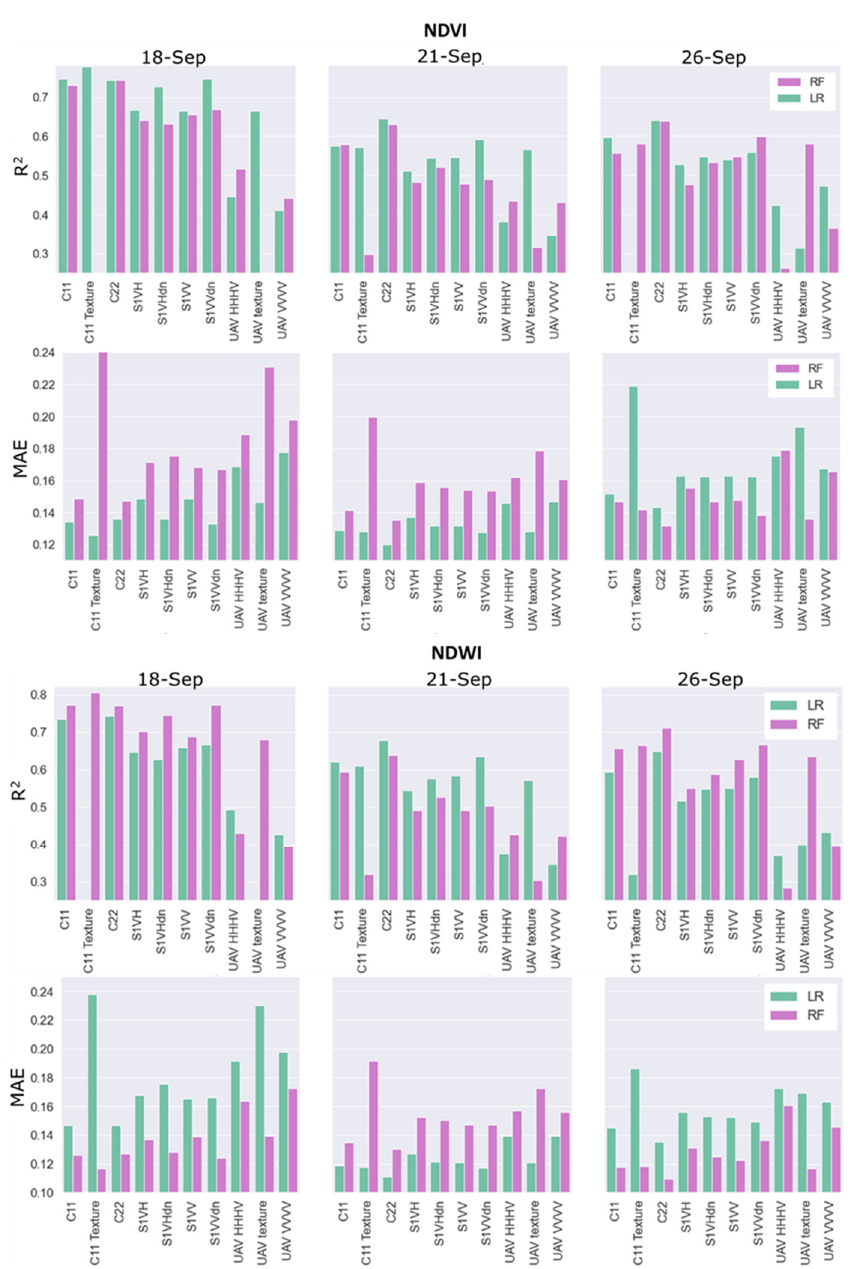
Figure 8. The top sub-plot shows NDVI and the bottom sub-plot shows NDWI. R 2 and MAE are shown for models computed using each variable individually in order to evaluate the impact of each variable on the model’s performance. The metrics were computed for 18 September 2018 when all three datasets (UAVSAR, Sentinel-1 and Sentinel-2) had imagery, as well as using multispectral imagery offset from the SAR imagery (21 September 2018, 26 September 2018). Linear Regression (LR) was compared against Random Forest (RF) for each dataset and date.